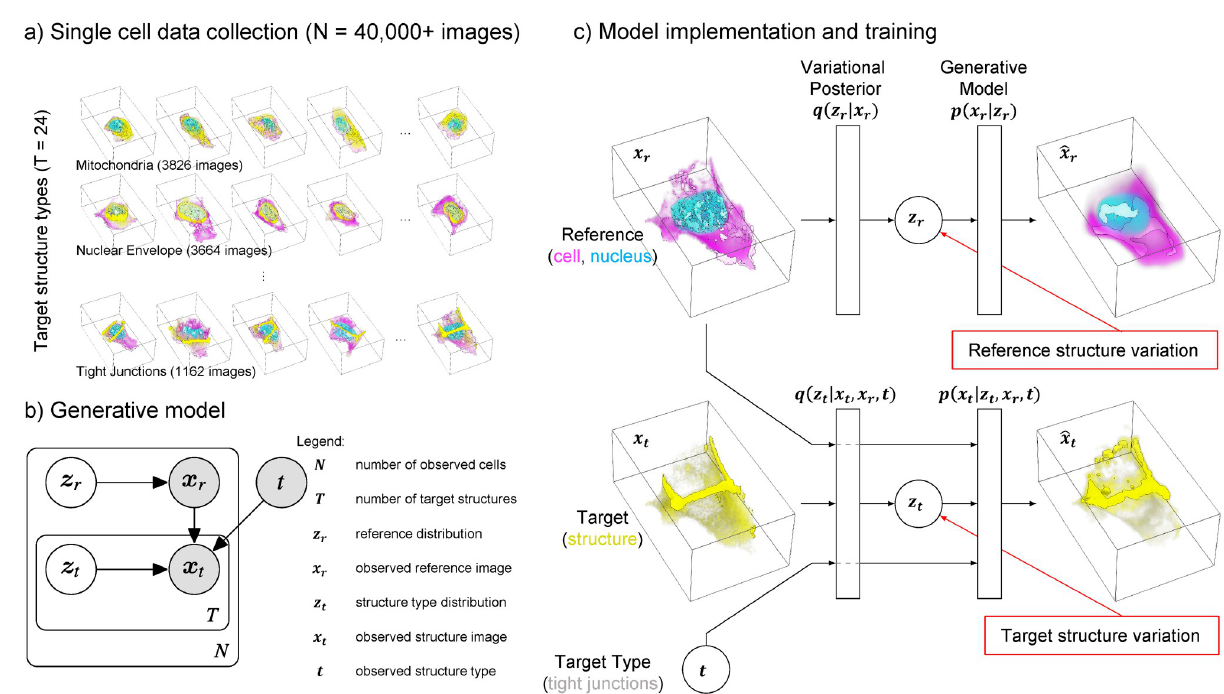
Fig 1. The statistical cell. a) A visual overview of the single-cell data collection used in this study. For each of more than 40,000 cells we have high- resolution 3D image data of the shape and location of the cell membrane (pink), nucleus (blue) and one of 24 endogenously tagged subcellular structures (yellow). The examples show actual image data of cells in the collection. b) Plate diagram of the Statistical Cell model. Shaded and un-shaded circles represent observed and learned variables, respectively. We model reference structures x x t as draws from the latent variable z t , conditioned on x r and target type t . c) The main components of the models are two autoencoders: one encoding the variation in the reference, i.e. the cell and nuclear shape (top), and another which learns the relationship between the target (the subcellular structures) dependent on the reference encoding